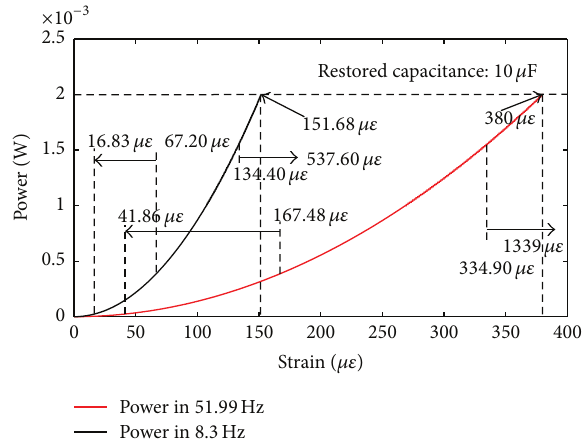
Figure 9: Energy harvesting effect of the EH MFC with the enhanced circuit.